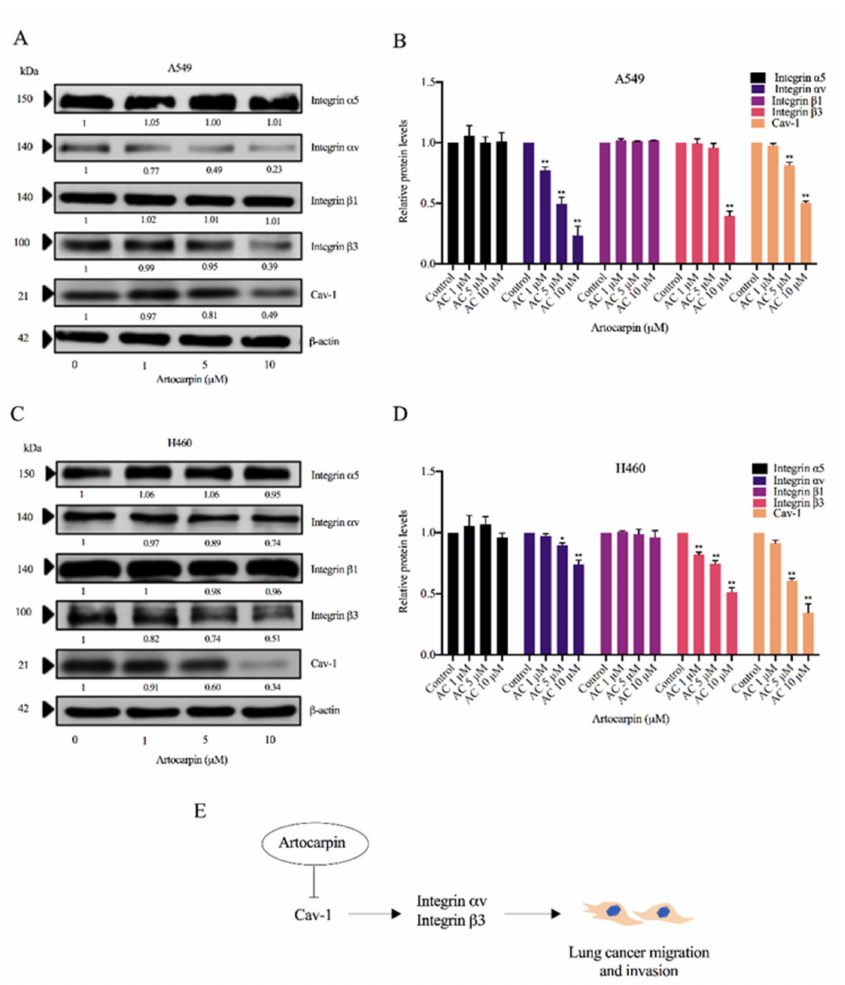
Figure 7. Effect of artocarpin on integrin expression. ( A ) A549 and ( C ) H460 cells were treated with artocarpin (0–10 µ M) for 24 h. The protein expression levels of integrins β 1, β 3, αν , α 5, and Cav-1 were investigated by Western blotting. ( B , D ) Relative protein expression levels were quantified using densitometry. Blotting membranes were probed with β -actin to confirm the equal loading of the samples. Data represent the mean ± SD ( n = 3). * p < 0.05, ** p < 0.01 versus non-treated control. ( E ) Schematic mechanism of artocarpin-mediated integrin switch in human lung cancer A549 and H460